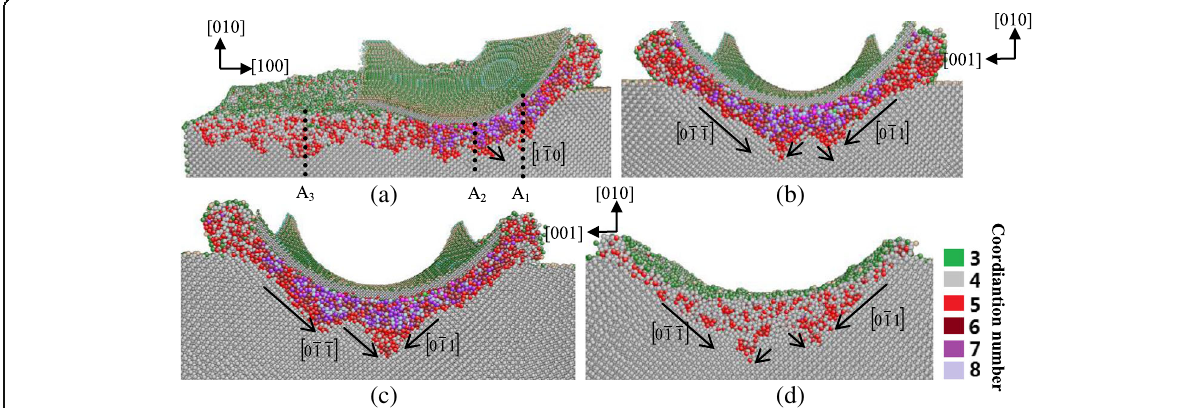
Fig. 6 Cross-sectional views of the subsurface deformation when nano-cutting along the [100] direction on the (010) plane. a On the (001) plane, passing along the [100] direction through the middle of the tool. b On the (100) plane, passing through A 1 . c On the (100) plane, passing through A 2 . d On the (100) plane, passing through A